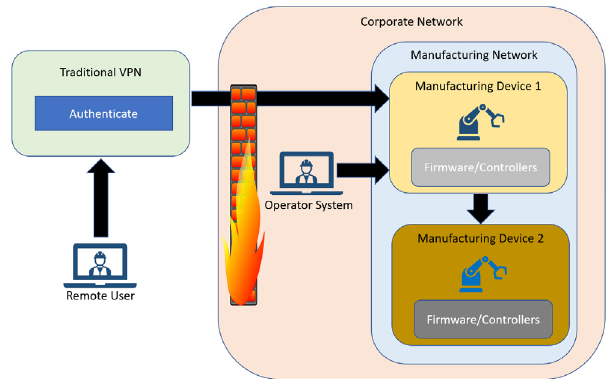
Figure 7. Current architecture of manufacturing industry without zero-trust.